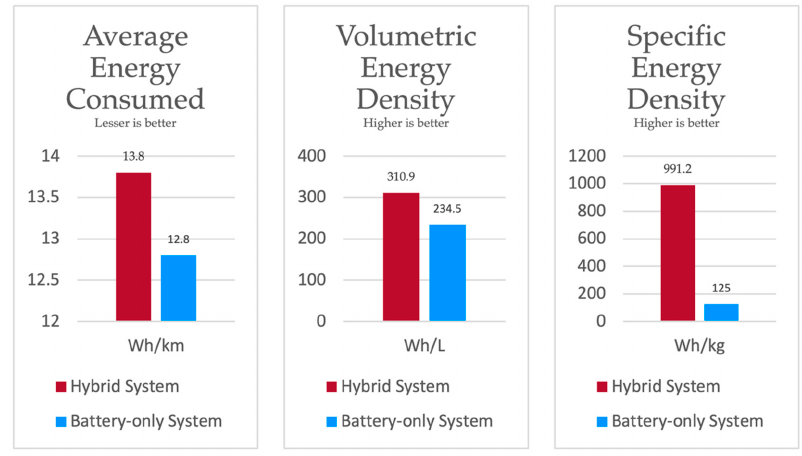
Figure 17. Comparison of systems.